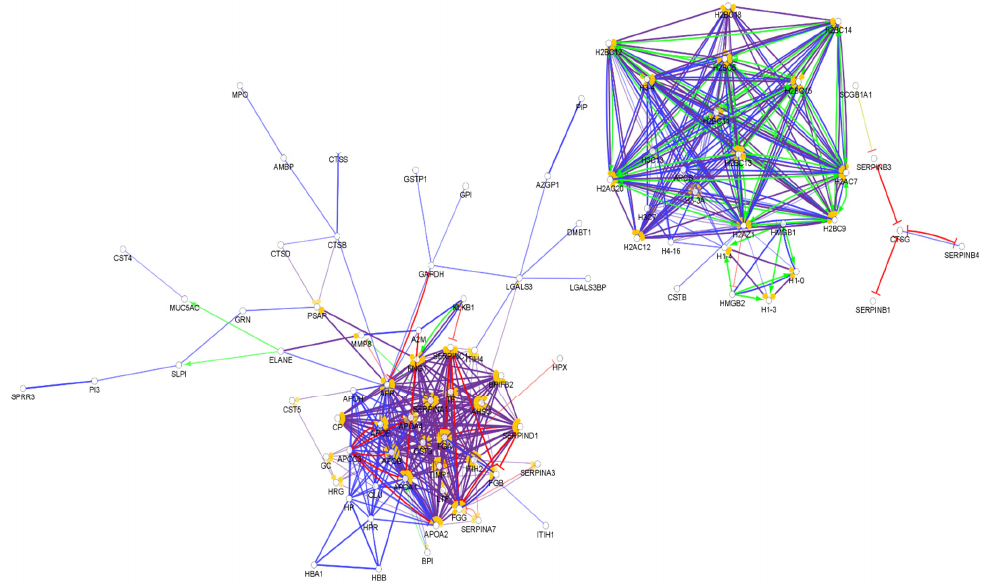
Figure 5. Partial network view of the interaction network of the chemical barrier proteins in the nasal secretion. Each circle represents a protein and the lines indicate interactions. The lines with an arrow represent activation, blocking lines represent inhibition, and simple lines represent protein–protein interaction. Line color indicates the type of interaction: green color refers to activation, red color to inhibition, blue color to binding, yellow color to co-expression, and purple color to catalysis. The proteins are labeled with their gene name. The high resolution and complete network image of this network is presented in Figure S5. Our analysis of the interactions among the nasal AMPs highlighted a similar pattern to the interactions found in saliva. The majority of the chemical barrier proteins in the